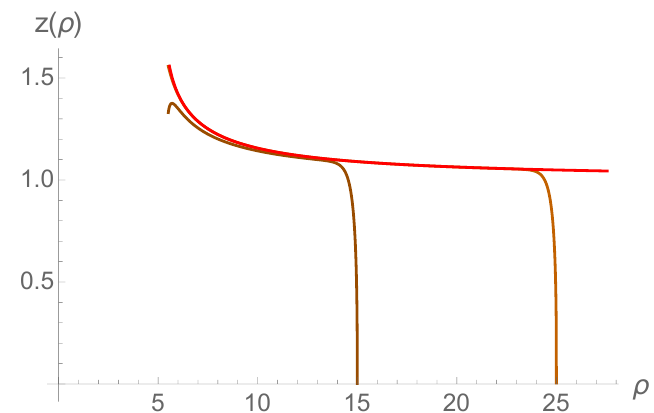
Figure 7. Demonstration that the scaling solution (4.12) indeed approximates the real extremal surfaces exponentially well. We took two extremal surfaces from (cid:12)gure 4; for R = 15 we have a Vaidya, while for R = 25 an end of the world brane extremal surface, but both corresponding to the same (cid:26) c . Note that in the Vaidya setup the extremal surface shoots up to the scaling solution quickly, as discussed in the main text. To reach the boundary, the extremal surfaces depart the scaling solution exponentially fast, as described by